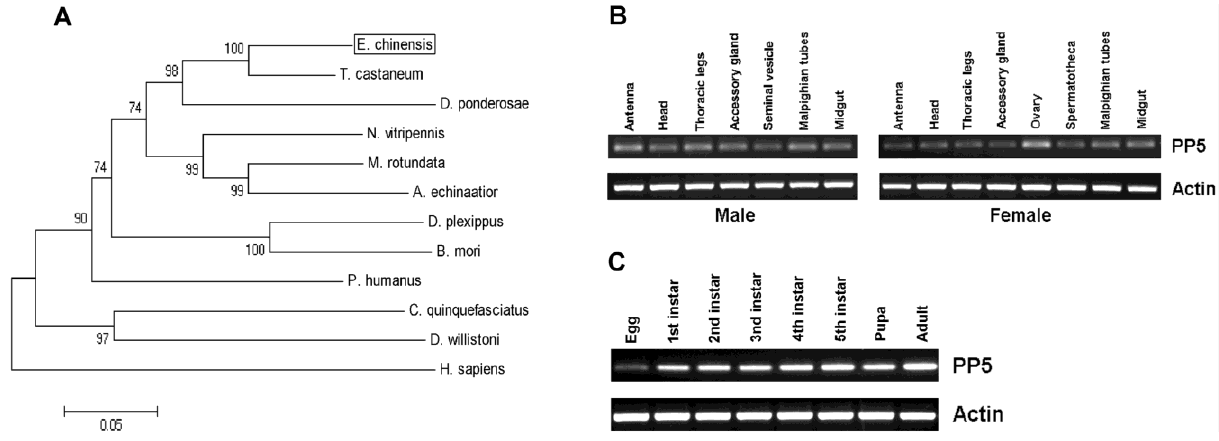
Figure 2. Phylogenetic tree construction and expression analysis of EcPP5 . ( A ) Phylogenetic analysis of EcPP5 with other insect PP5s; ( B ) RT-PCR analysis of EcPP5 expression in different tissues of male and female adults; and ( C ) RT-PCR analysis of EcPP5 expression in various developmental stages. The actin gene ( EcActin ) was used as the reference